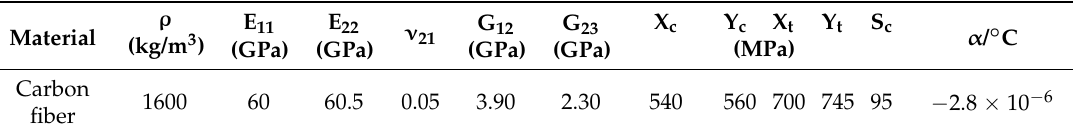
Figure 1. Different woven fibers weave patterns [40]. Table 3. Twill weaves carbon fiber/epoxy properties [41].